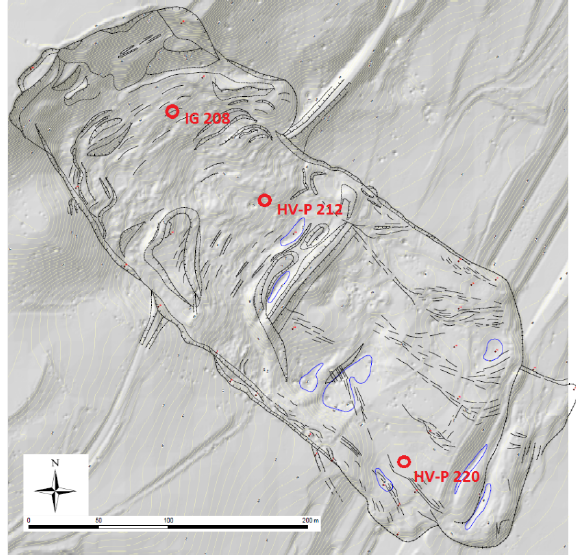
Figure 2. Map of the landslide with sampling